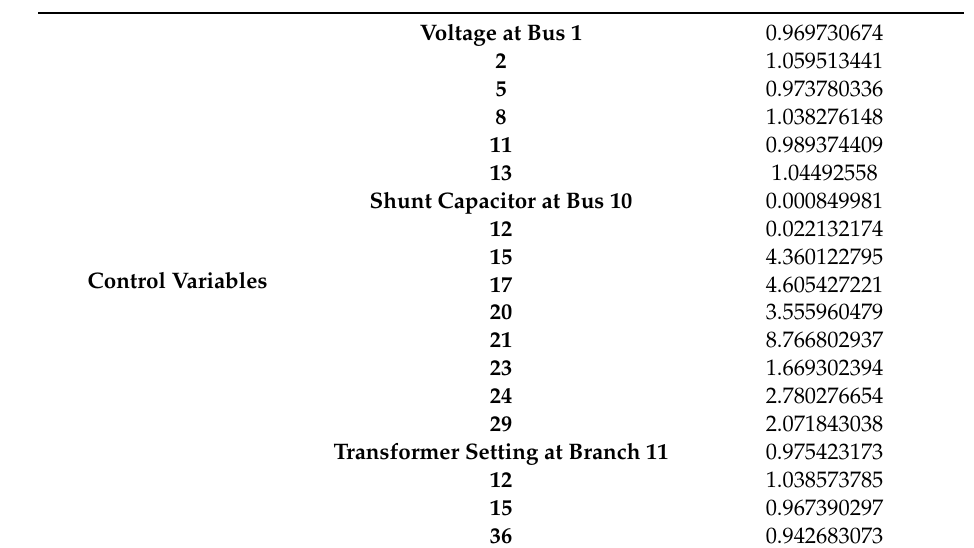
Table 2. 30-bus system decision variables for the first case.